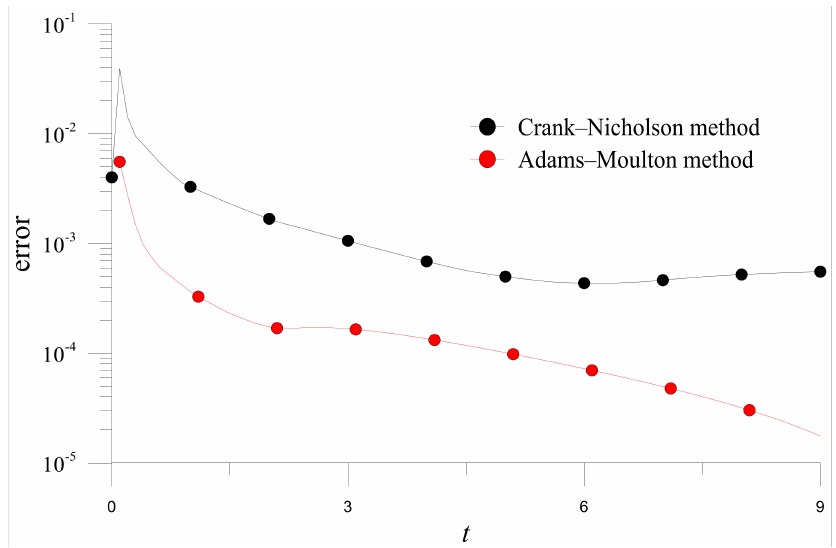
Figure 8. Errors of numerical solutions obtained by the Crank-Nicholson and Adams-Moulton methods for Example 1 ( ∆ t = 0.025, c = 1, and N = 304